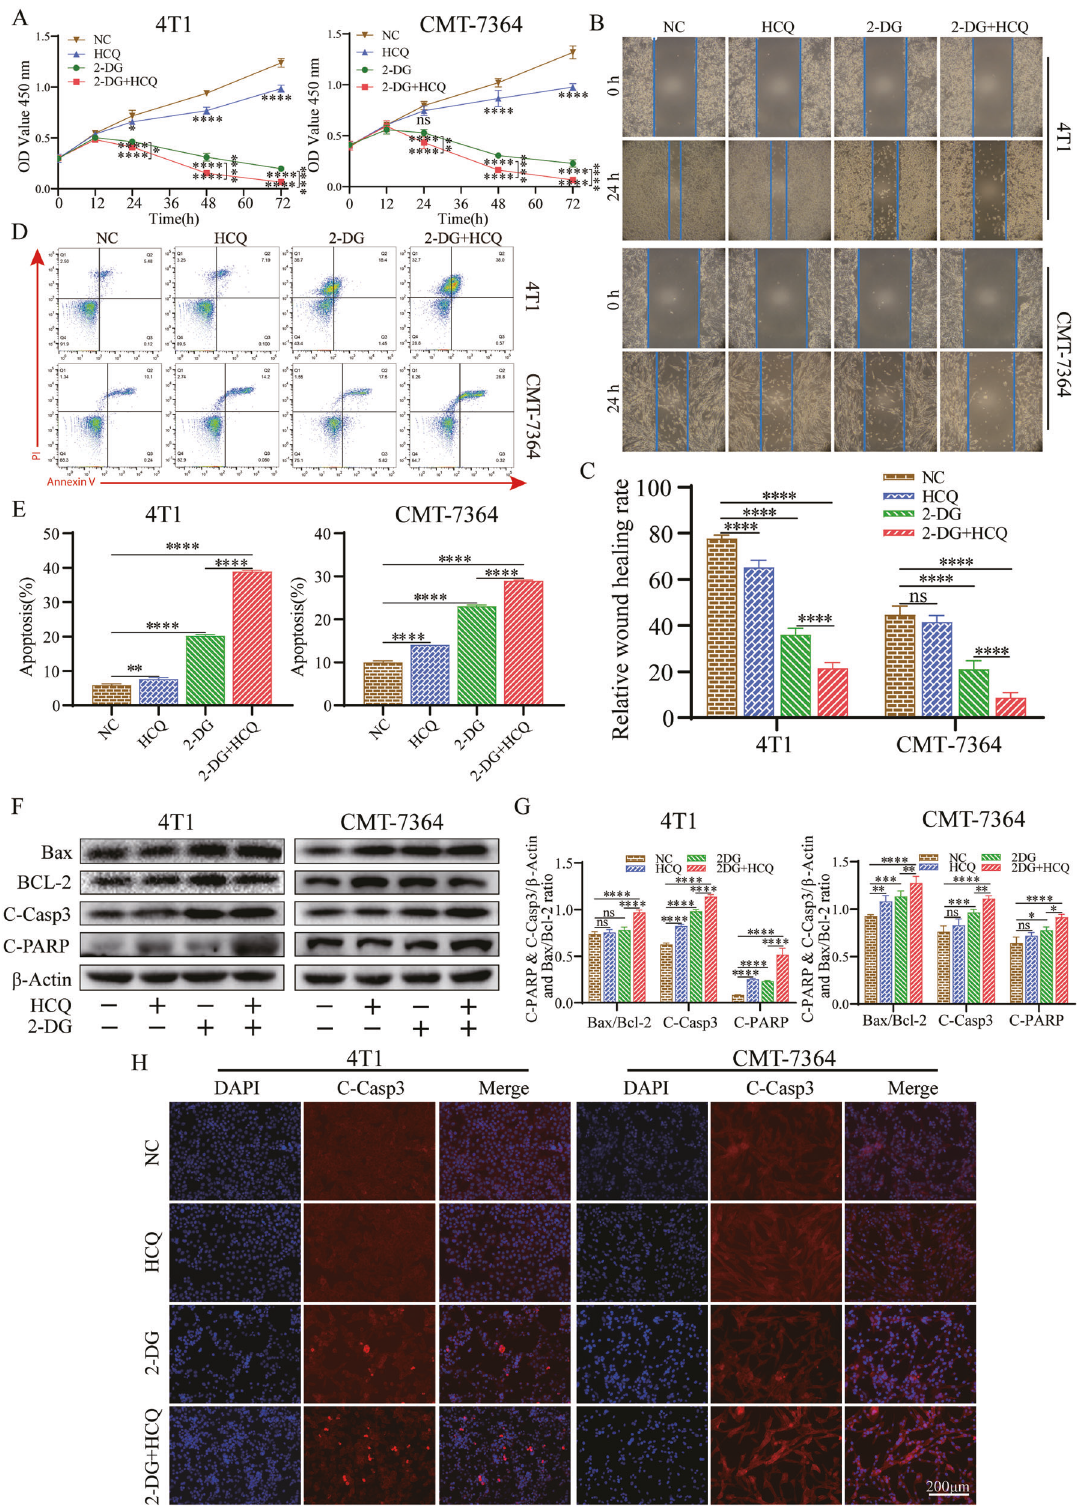
than those of 2-DG group, HCQ group and NC group, illustrating severer pathological changes of the tumour in situ treated with 2-DG and HCQ. In addition, the degree of nuclear fragmentation in tumour cells was similar in 100 mg/kg 2-DG group and 50 mg/kg 2-DG combined with HCQ group,